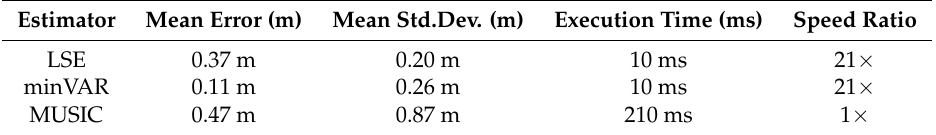
Table 1. Simulated localization estimations of all the cases (N = 10 localizations for each ( x , y )